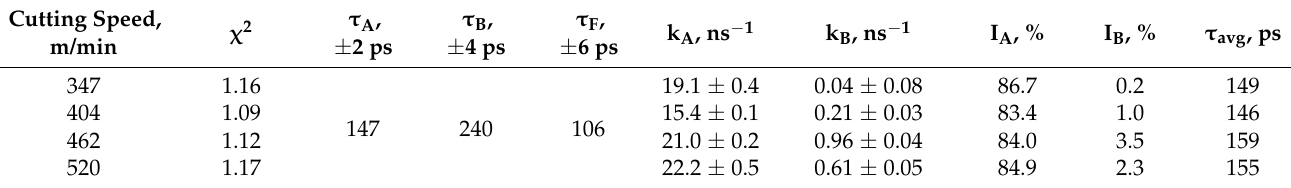
Table 3. PALS parameters of GCr15 samples depending on cutting